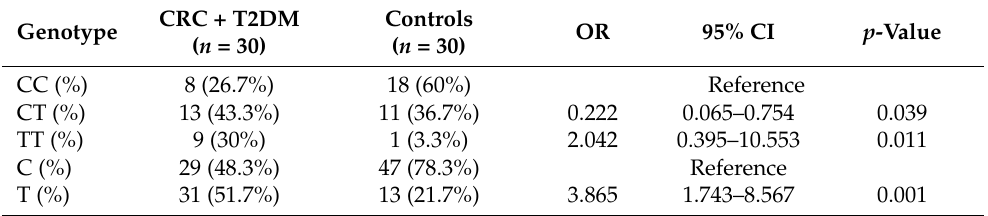
Table 5. Genotype and allele distribution and analysis of the association of rs7903146 of TCF7L2 in subjects with CRC + T2DM and controls.